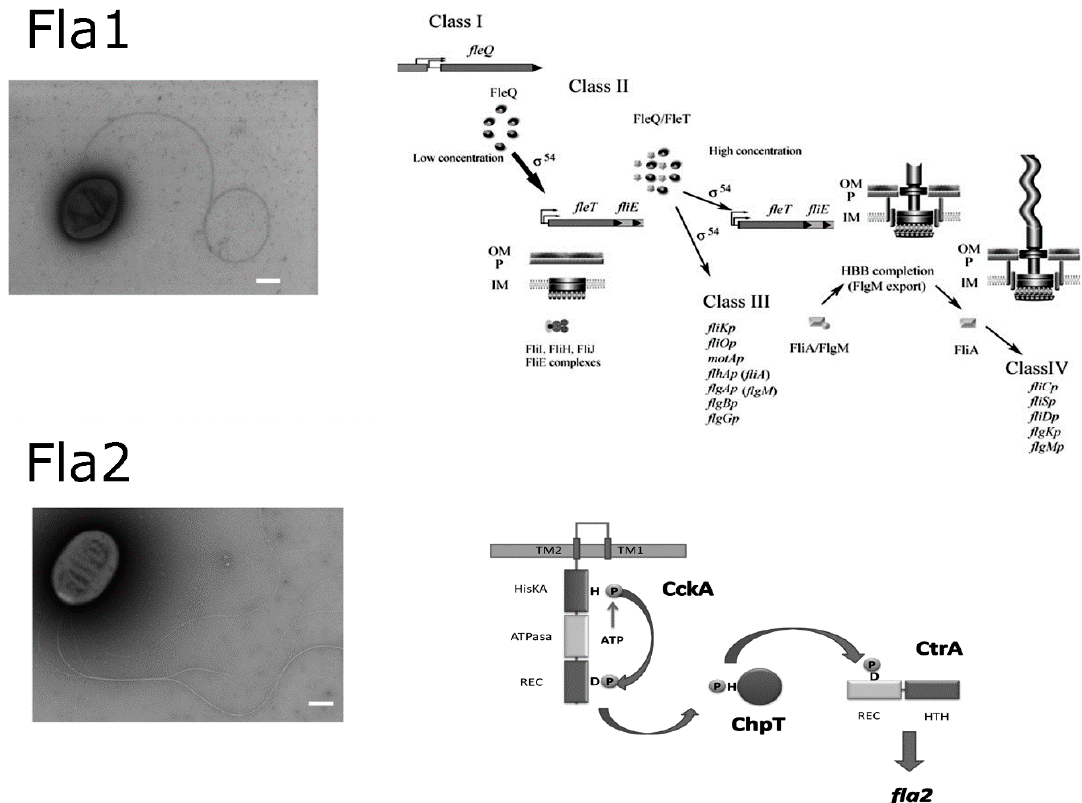
Figure 2. Electron micrograph showing Rhodobacter sphaeroides expressing either the Fla1 flagellum or Fla2 flagella. Cells were grown separately and under different growth conditions (for details see, [62]). Bar = 500 nm. The schemes showing the regulatory pathway of each flagellar system are shown at the right side of each micrograph [60,61].